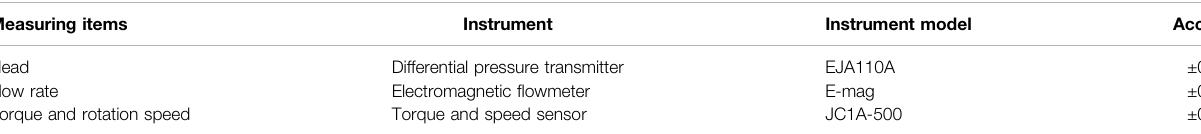
TABLE 2 | Main test instruments of test